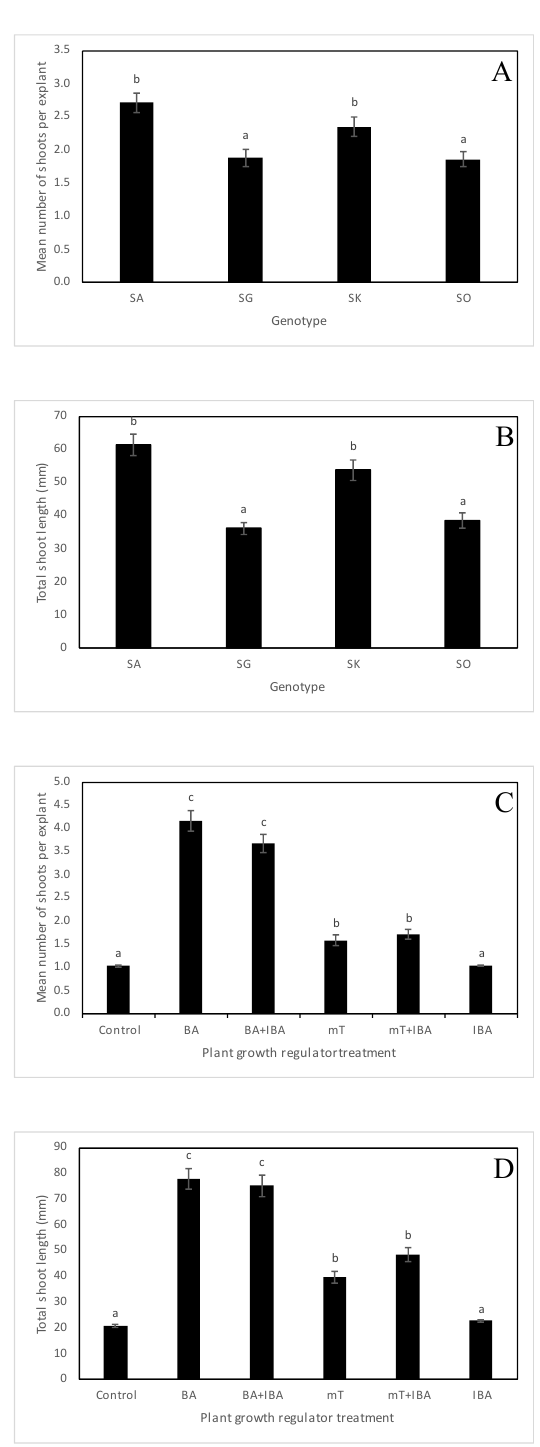
Figure 1. Shoot production in Sorbus species cultured with different combinations of N 6 -benzyladenine (BA), indole-3-butyric acid (IBA) and meta -topolin ( m T), applied at 0.5 mg · L − 1 , 0.1 mg·L − 1 and 0.5 mg · L − 1 , respectively. ( A , B ) The effect of genotype on the mean number of shoots per explant ( A ) and the total shoot length ( B ). ( C , D ) The effect of plant growth regulator (PGR) treatment on the mean number of shoots per explant ( C ) and on the total shoot length ( D ). Values are mean standard errors. In each graph, different letter(s) on the bars show significant differences according to Tukey’s range test ( p -value = 0.05). Sorbus × abscondita (SA), S. gemella (SG), S. × kitaibeliana (SK), S. omissa